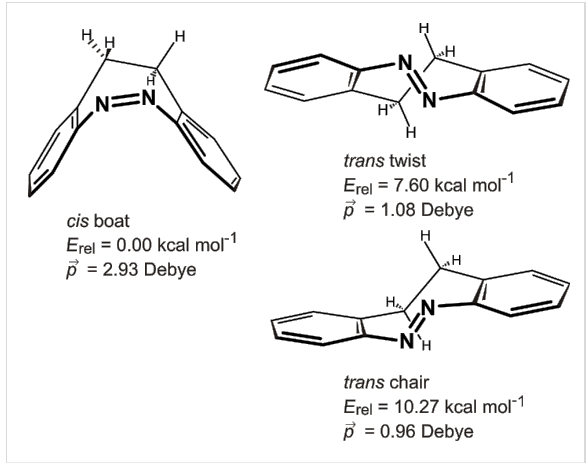
Figure 1: Configurations and conformations of 5,6- dihydrodibenzo[ c , g ][1,2]diazocine ( 1 ), and DFT (B3LYP/6-31G*) calcu- lated energies (kcal mol − 1 ) relative to the most stable cis boat form. Dipol moments are given in